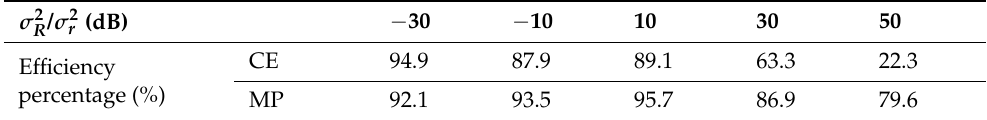
Table 2. Efficiency percentage of CE and MP methods (Simulation